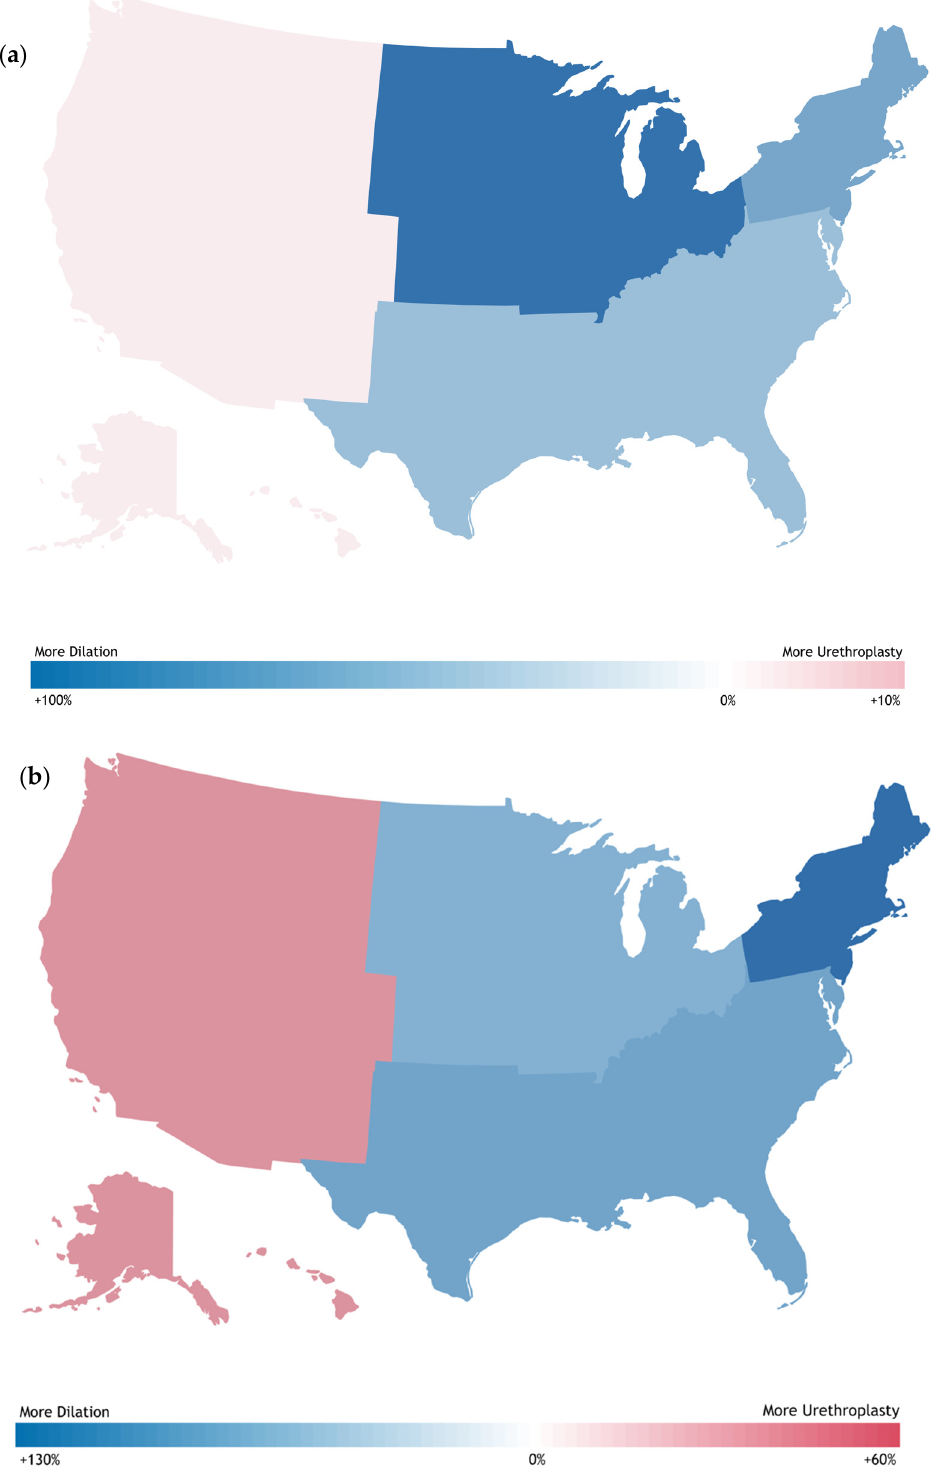
Figure 2. United States Maps Showing Geographic Distribution of ( a ) Male and ( b ) Female Urethroplasty–Endoscopic management Ratios in 2022 by Census Region.